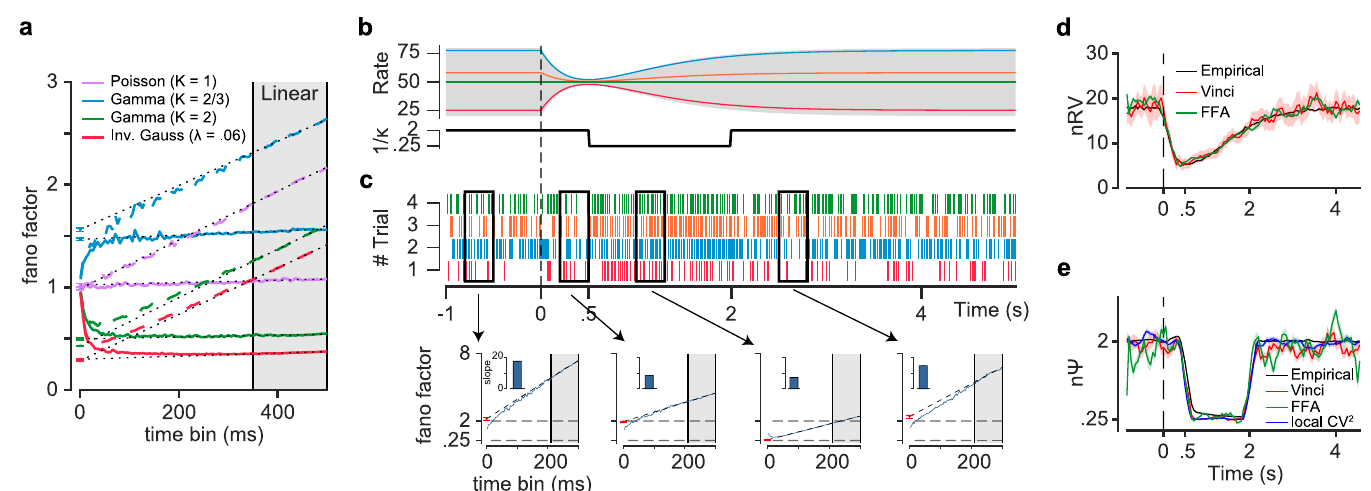
Fig 1. Parsing components of variability in doubly stochastic renewal processes in time. (a) Fano factor (FF) as function of time-bin for simple (solid lines) and doubly stochastic (dashed lines) renewal processes with different ISI distributions (exponential, gamma and inverse gaussian). The asymptotic part of FF for large time- bins (gray shaded area) is used for independent estimates of normalized spiking irregularity (n C ) as the intercept and the normalized rate variability (nRV) as the slope. Note the non-zero slopes for doubly stochastic processes ( λ ~ N ( μ = 50Hz, σ = 10Hz)). (b) Rate parameter ( l ¼ 1 ) and inverse of shape parameter ( 1 ) for a doubly i (cid:0) � ky k (cid:0) 2 t þ where n � 1 (cid:0) 5 t ~ N (0, 30) and t + is time for stochastic gamma process as a function of time. Rate parameter was variable across trials according to 50 þ n i þ e i positive values and zero otherwise. (c) top, raster plot shows multiple trial realizations from the stochastic gamma process (rate of each trial is indicated in panel b), bottom, FF as a function of time-bin (0-300ms), blue curve represents FF estimates as a function of time. Dashed line shows extrapolation of fitted line to the linear portion of FF; red dot represents intercept. Slopes of each line are indicated by bar plots. (d) nRV estimates made empirically by assuming access to a large number of realizations of each trial with given parameters (black, empirical estimates see S1 Text) along with estimates using smoothed FFA (green) and Vinci (red) methods. (e) same format as d but for n C estimates. Blue trace represents CV 2 . Error bars and shades indicate the sem. local